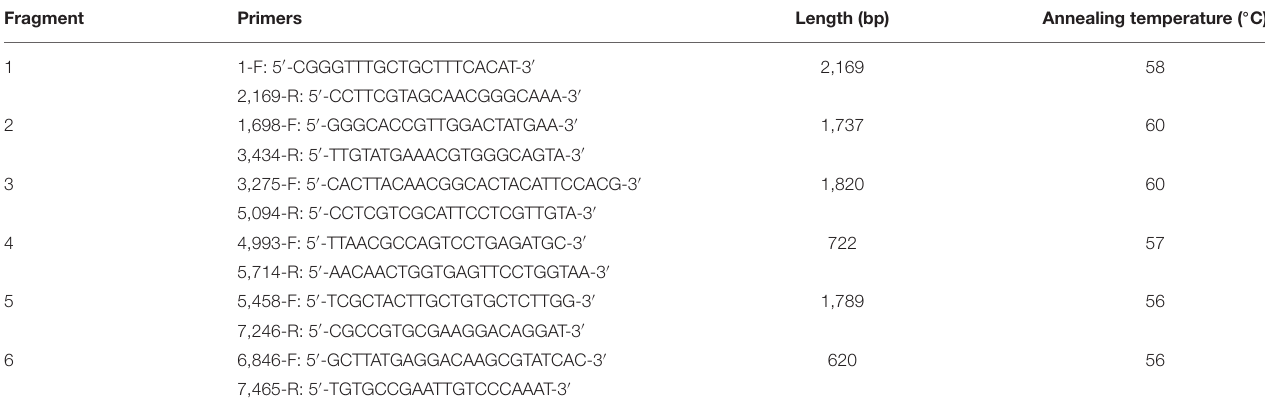
TABLE 1 | RT-PCR primers used in this study. Fragment